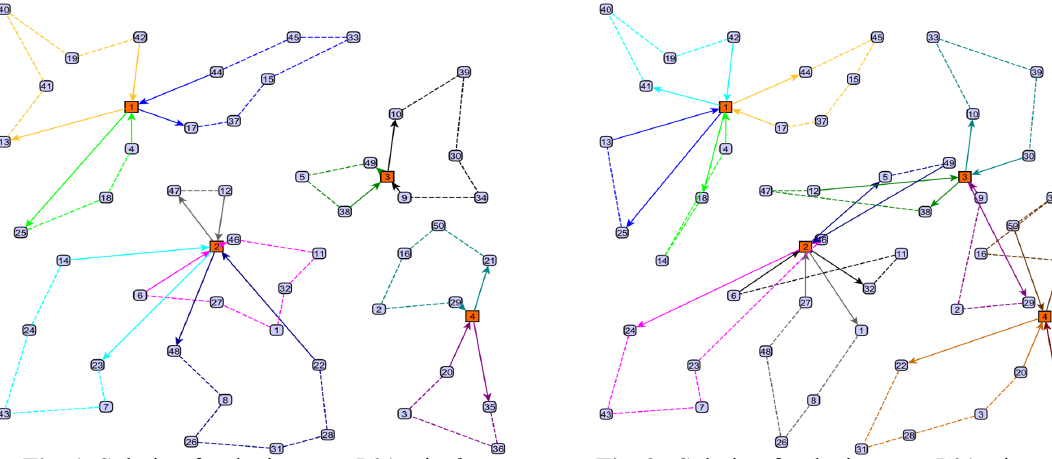
Fig. 1. Solution for the instance P01 min fo 1 Fig. 2. Solution for the instance P01 min-max